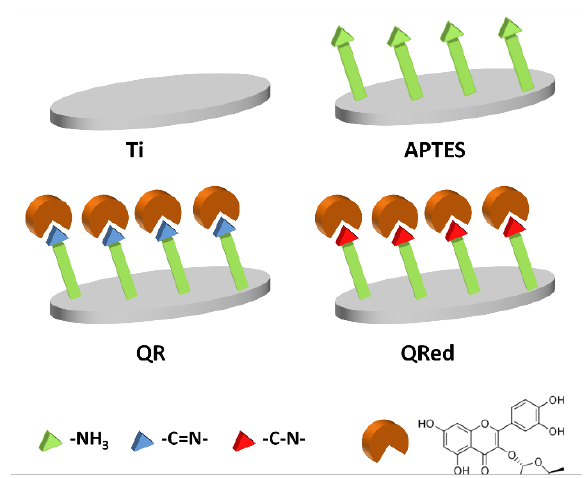
Figure 1. Scheme of the surfaces used in the study. Ti and aminosilanized (APTES) surfaces were used as controls. Quercitrin was covalently grafted to the surfaces in two manners: either by reaction of the carbonyl group of quercitrin with the amino (-NH 3 ) terminal group of the aminosilane to give an imine (-C=N-) bond (QR samples) or by adding a reducing agent to the grafting reaction to obtain a single C-N bond between the flavonoid and the silane (QRred samples).